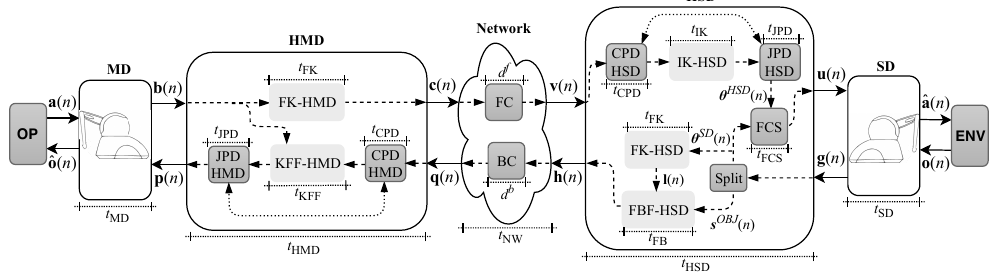
Figure 4. Detailed discrete model of a tactile internet